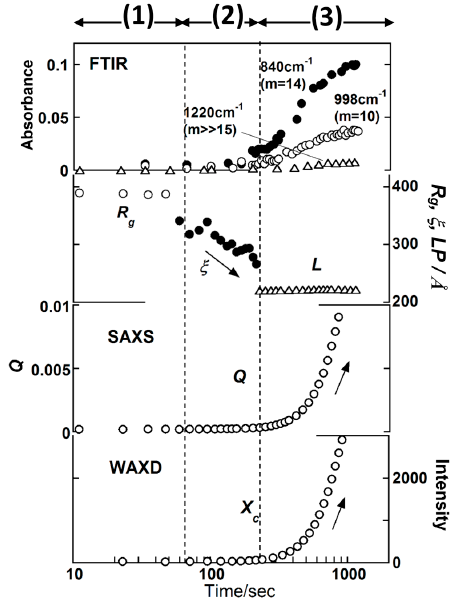
Figure 4. Time dependence of the IR band intensity, the SAXS structural parameters, and the WAXD crystallinity X c estimated in the isothermal crystallization process of it -PP, where the degree of super cooling ∆ T = T ∞ − T c = 61 ◦ C for the equilibrium melting temperature T ∞